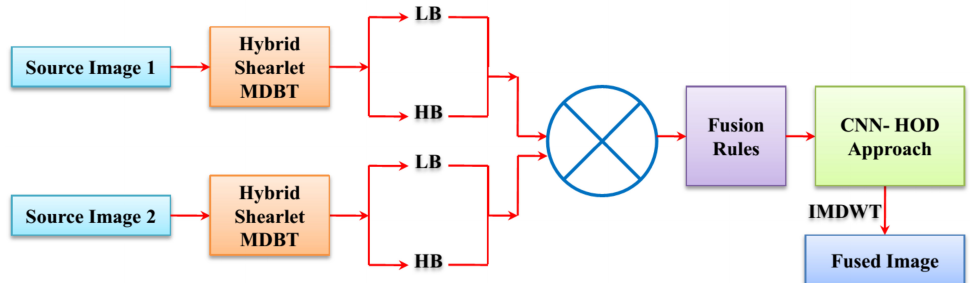
Figure 1. Block schematic of the proposed multimodal medical image